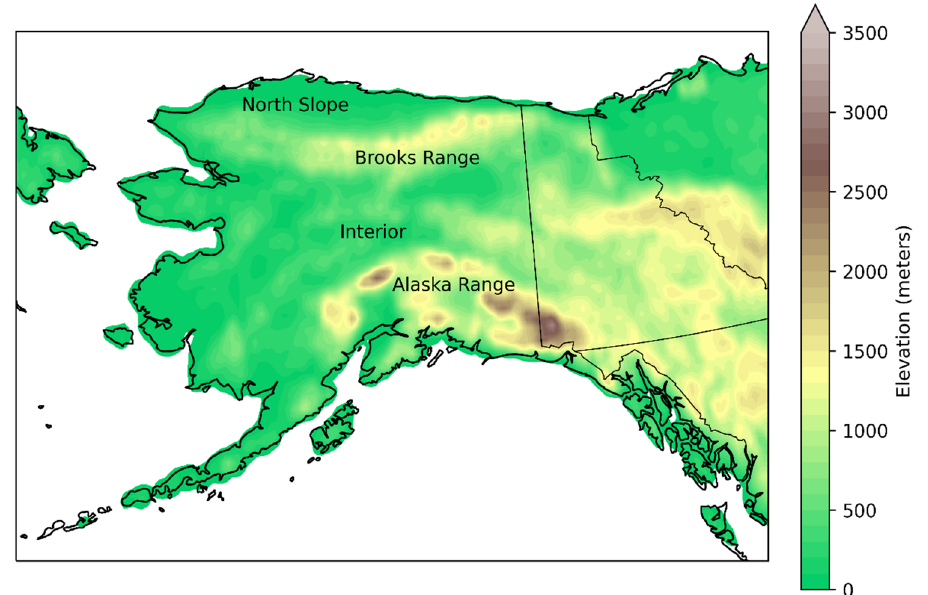
Figure 1. Alaska topography and geographic features. Elevation data from the National Center for Atmospheric Research (NCAR) TerrainBase, Global 5 Arc ‐ minute Ocean Depth and Land Elevation from the U.S. National Geophysical Data Center (NGDC). https://rda.ucar.edu/datasets/ds759.2/ (Accessed on 10 March 2022). The 5 Arc ‐ minute data from NGDC have been coarsened to 25 km resolution for compatibility with the model simulations (Section 2).